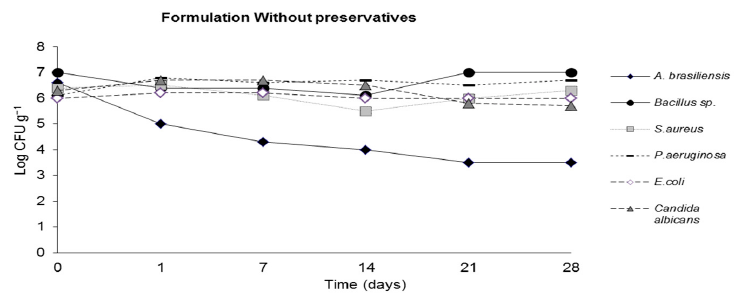
Figure 6. Growth inhibition of different microorganisms in body milk formulations without preservatives (negative control).